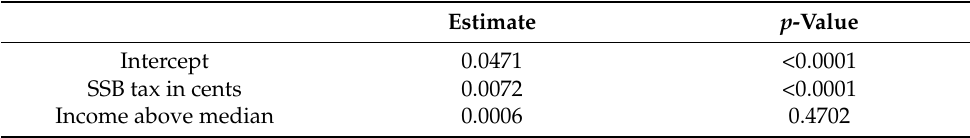
Table 4. Average CSD Prices Paid by Study